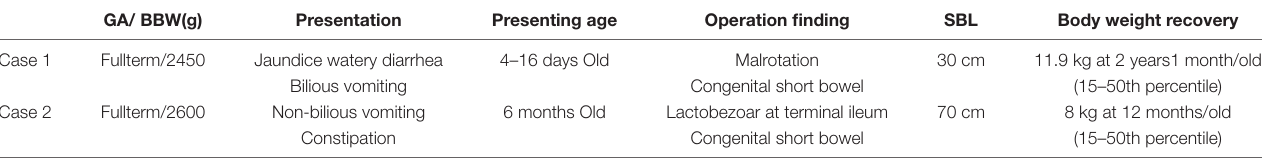
TABLE 1 | Clinical features in two siblings.